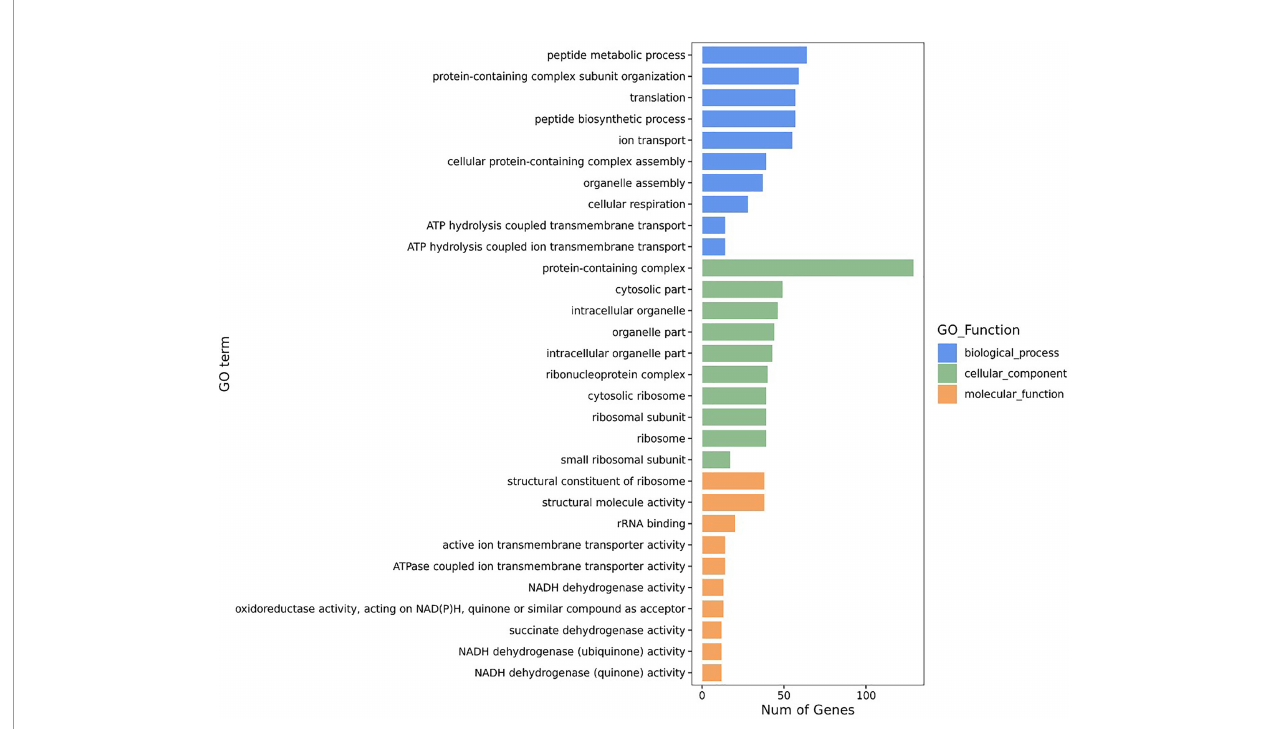
FIGURE 2 | GO enrichment analyses of